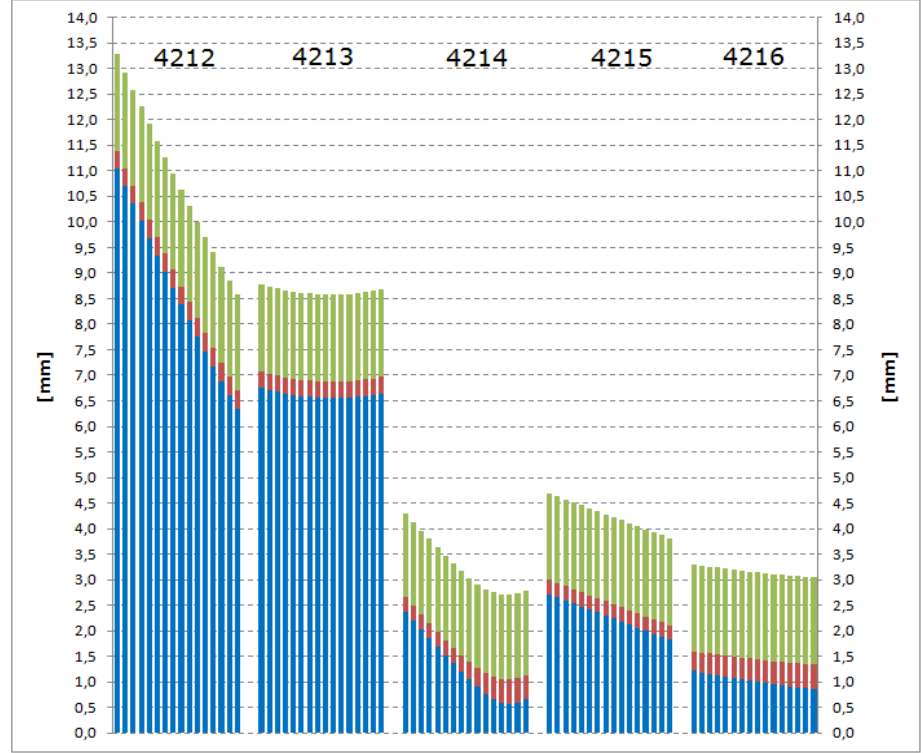
Figure 11. 3D displacement vectors (blue bars), standard deviations of displacements (red bars) and positional standard deviations of representative points T of displacement vectors (green bars, maximal values of T deviations are shown). The identical points T observation